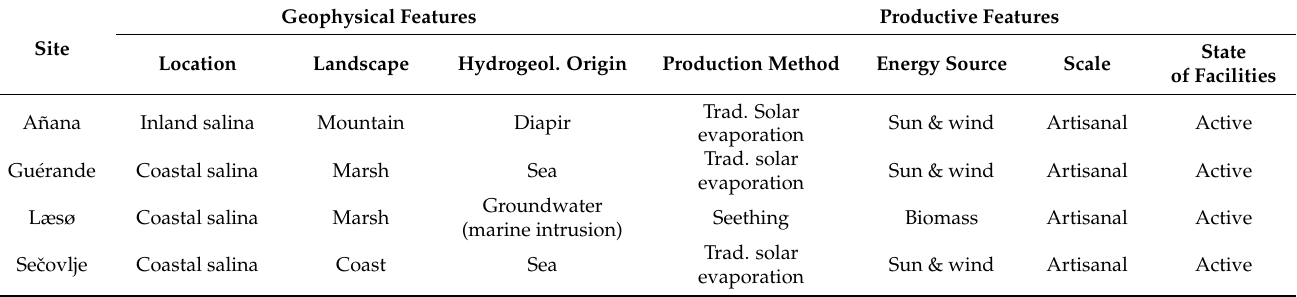
Table 1. Description of case study sites according to different criteria. Own